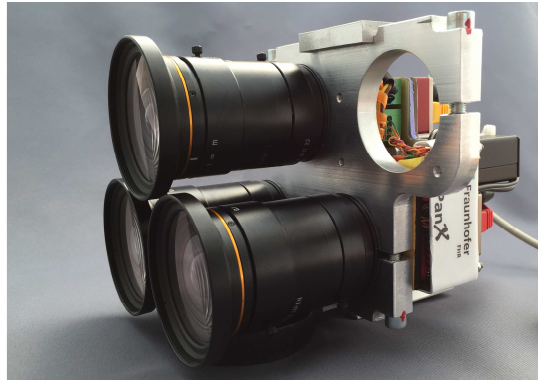
Figure 12. Three channel configuration of the PanX system for NDVI